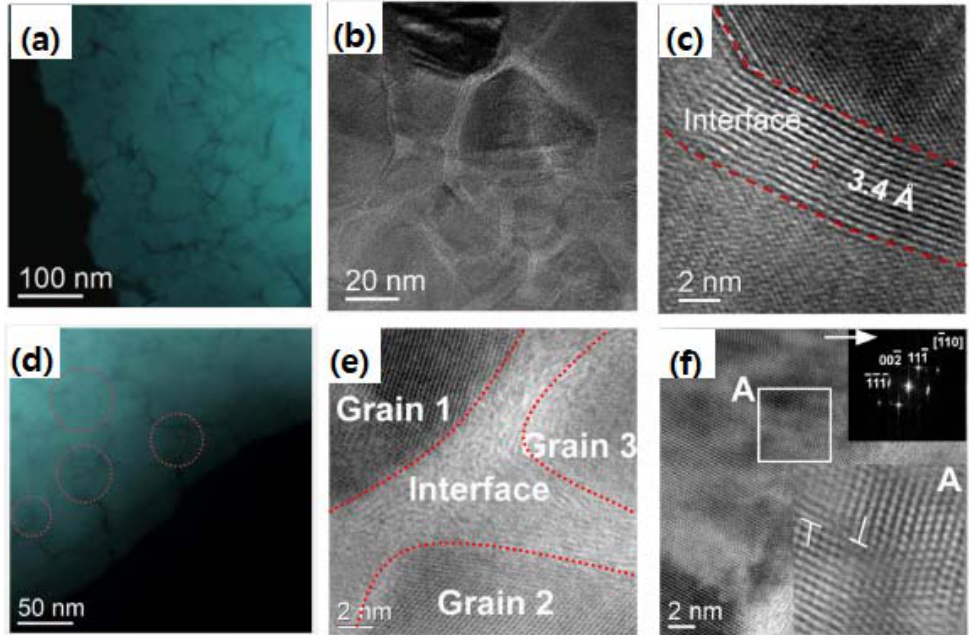
Figure 11. ( a ) Dark ‐ field STEM and ( b ) magnified TEM image, showing n ‐ SiC grains surrounded by evenly distributed carbon at GB. ( c ) HRTEM image of pristine n ‐ SiC, showing graphitic lattice of carbon interface at GB. ( d ) Dark ‐ field STEM image after deformation of n ‐ SiC by indentation. ( e ) BF ‐ STEM micrograph of n ‐ SiC after deformation, showing highly disordered carbon interface at GB. ( f ) BF ‐ STEM micrograph on [110] direction of n ‐ SiC, showing dislocation along {111} plane and the corresponding FFT pattern (given in the inset). Reproduced with permission from [69]. Copyright 2022 Elsevier.